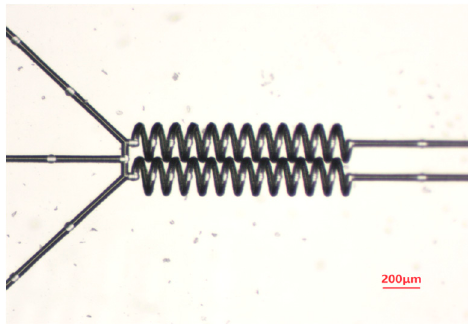
Figure 3. Small spacing structure of a multiple channel mixer.